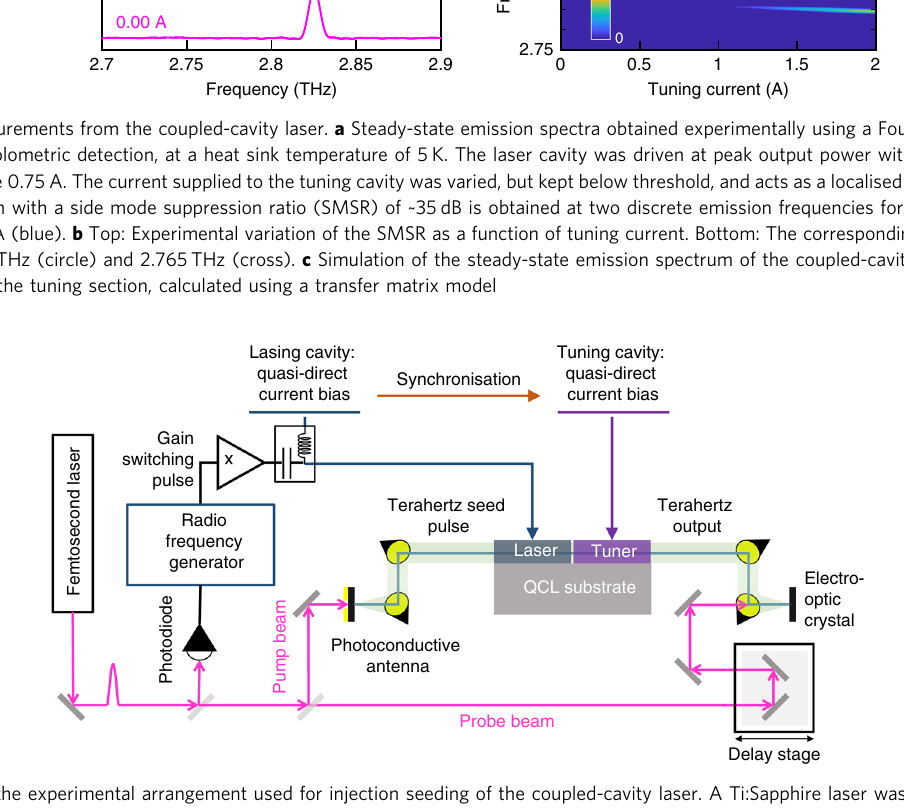
Fig. 2 Illustration of the experimental arrangement used for injection seeding of the coupled-cavity laser. A Ti:Sapphire laser was used to generate femtosecond pulses, a fraction of the power was used to trigger a radio frequency source to generate gain switching pulses. The remaining power was split to form a pump beam and a probe beam. The pump beam was focused onto a photoconductive antenna to generate broadband terahertz pulses. These terahertz pulses were used to injection seed the lasing section of the coupled-cavity laser. The terahertz fi eld emitted from the facet of the tuning section was sampled using an electro-optic crystal with the time-delayed probe beam. The gain switching pulses were combined with quasi-direct current pulses using a bias tee to drive the lasing cavity above threshold. A second quasi-direct current pulse generator was synchronised with the fi rst pulse generator and was used to drive the tuning cavity